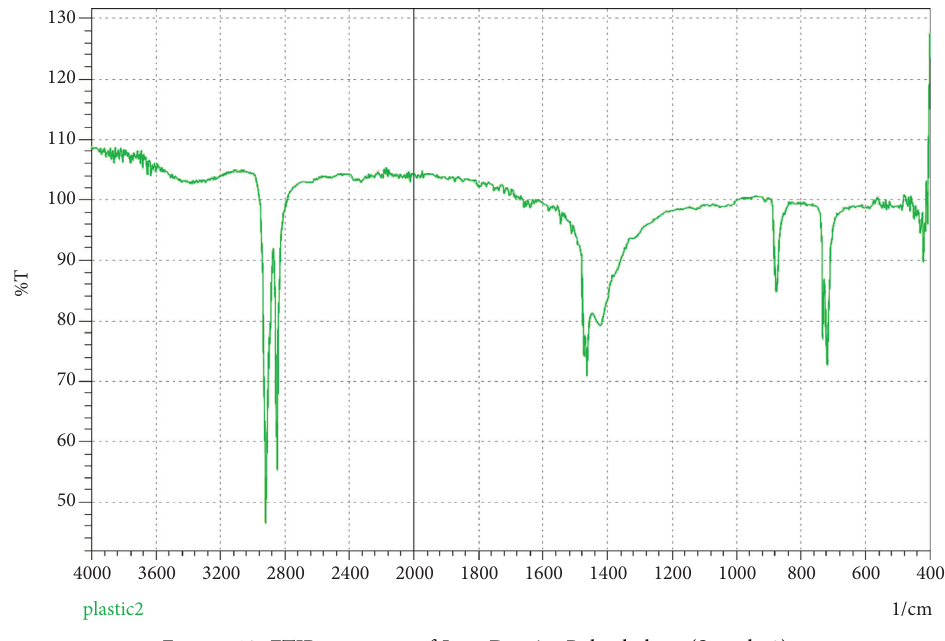
Figure 13: FTIR spectrum of Low-Density Polyethylene (Sample 2).